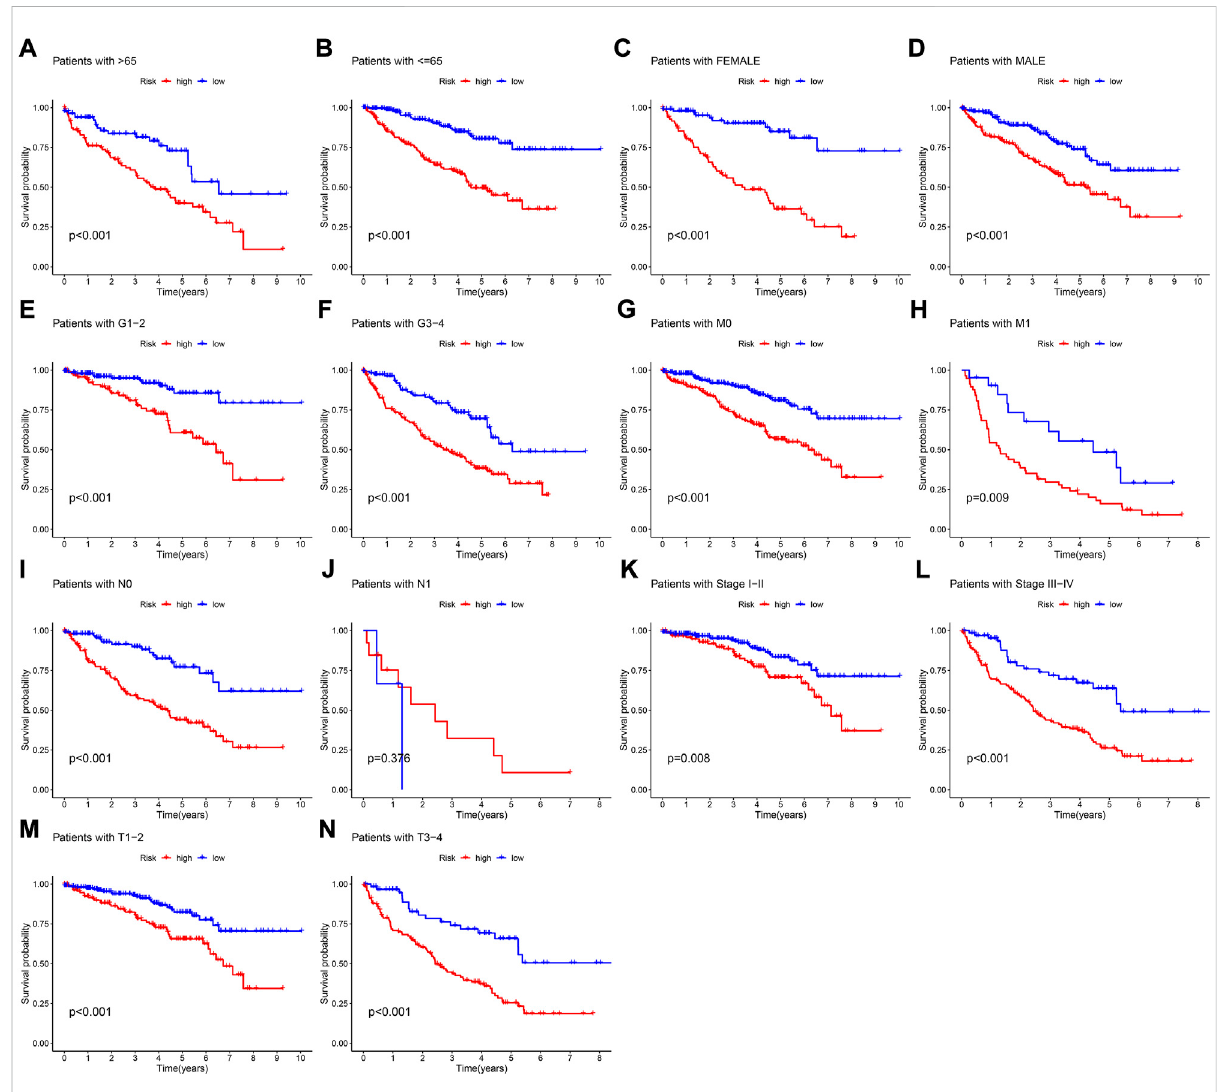
FIGURE 7 K-Msurvivalcurvesofpatientswithdifferentclinicaltraits. (A) Age > 65rankedbyriskscoreforOS. (B) Age < =65rankedbyriskscoreforOS. (C) Female ranked by risk score for OS. (D) Male ranked by risk score for OS. (E) Grade1-2 ranked by risk score for OS. (F) Grade3-4 ranked by risk score for OS. (G) M0ranked byriskscorefor OS. (H) M1ranked byriskscore forOS. (I) N0ranked byriskscore forOS. (J) N1ranked byriskscore forOS. (K) Stage I-II ranked by risk score for OS. (L) Stage III-IV ranked by risk score for OS. (M) T1-2 ranked by risk score for OS. (N) T3-4 ranked by risk score for